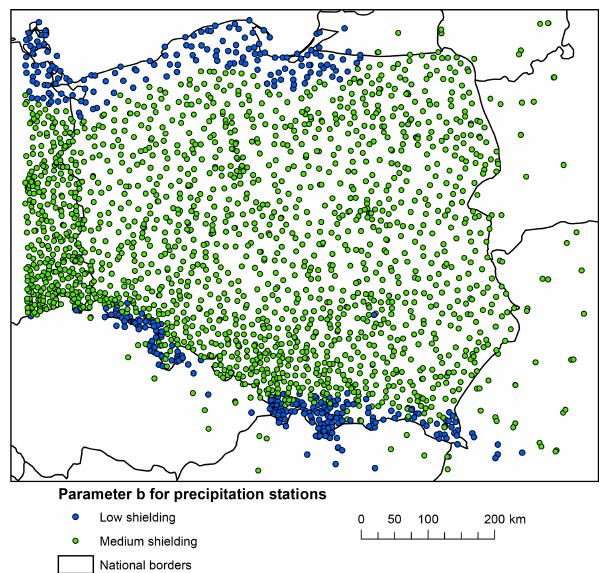
Figure 10. The Richter (1995) parameter b value groups for differ- ent precipitation stations.